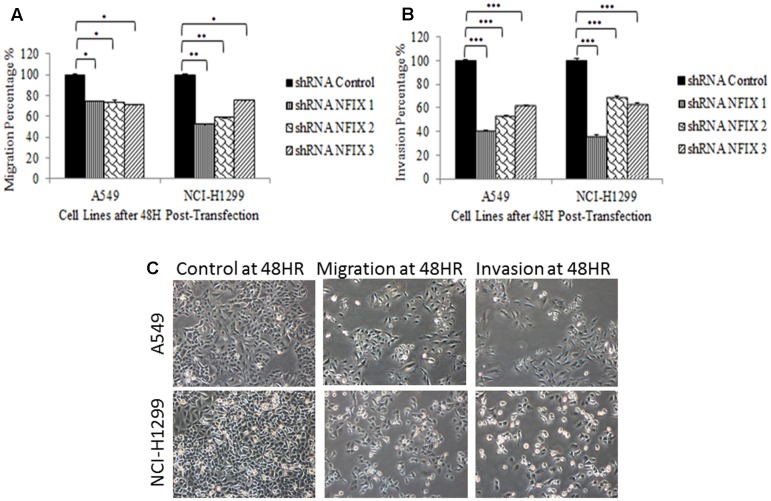
Reduction in cellular migration and invasion activities at 48 h post-transfection. (A) All NFIX shRNAs decreased migration in both cell lines. (B) All NFIX shRNAs significantly reduced invasion in both cell lines. (C) Transwell migration and invasion assays compared with each control cell lines. (∗p < 0.01; ∗∗0.01 < p < 0.05; ∗∗∗p < 0.05).